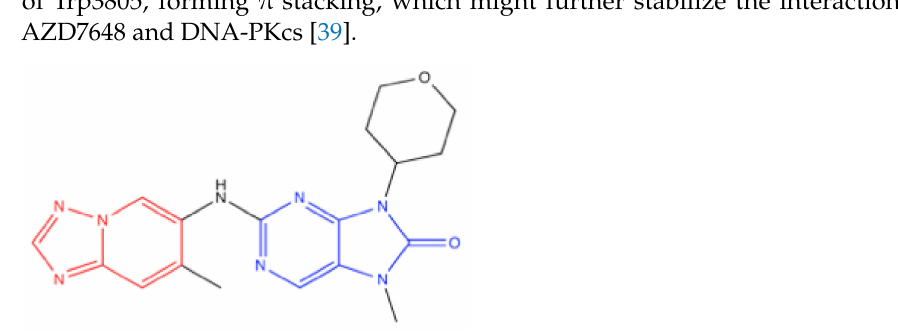
Figure 14. Structure of AZD7648. Red: triazopyrimidine structure, blue: purinone structure. AZD7648 sensitized cells to IR and doxorubicin at submicromolar concentrations